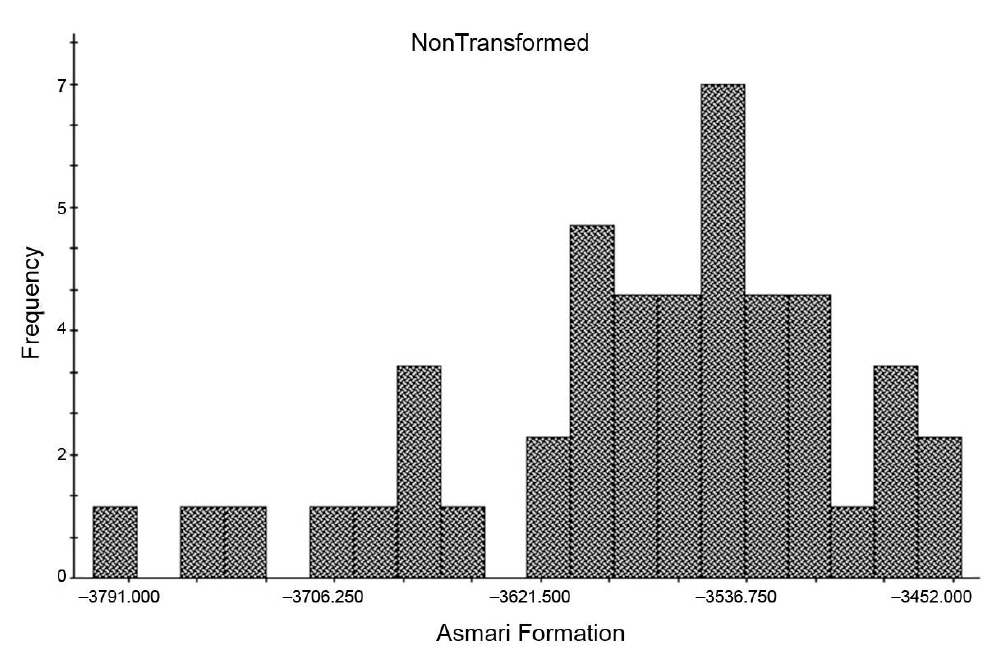
Fig. 2. Frequency distribution of data